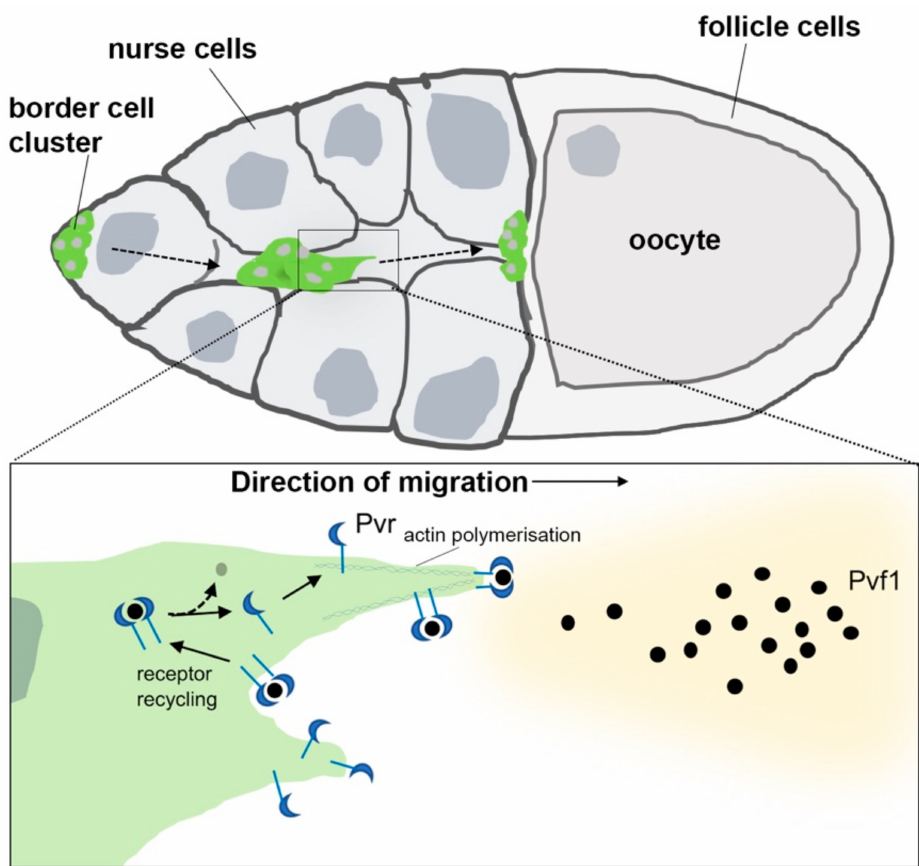
Figure 2. Pvr-Pvf1 mediated collective migration of border cells in the Drosophila ovary. Pvf1 emanating from the posteriorly located oocyte stimulates the collective migration of the border cell cluster toward its anterior boundary during oogenesis. Activation of Pvr by Pvf1 (black dots) at the leading-edge drives actin polymerization within invasive foci (inset). This is maintained by local receptor recycling (solid arrows) following endocytosis, complex disassembly (dotted arrow), then tra ffi cking back to the cell